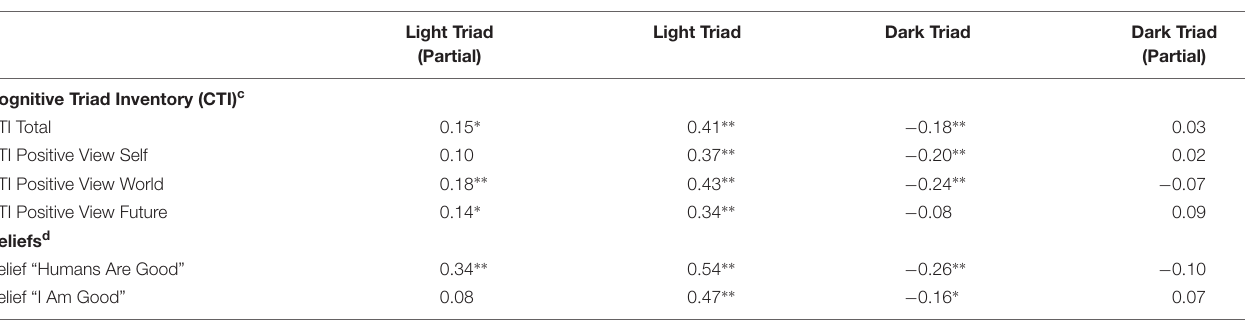
TABLE 10 | Correlations and partial correlations between worldview and light vs. dark